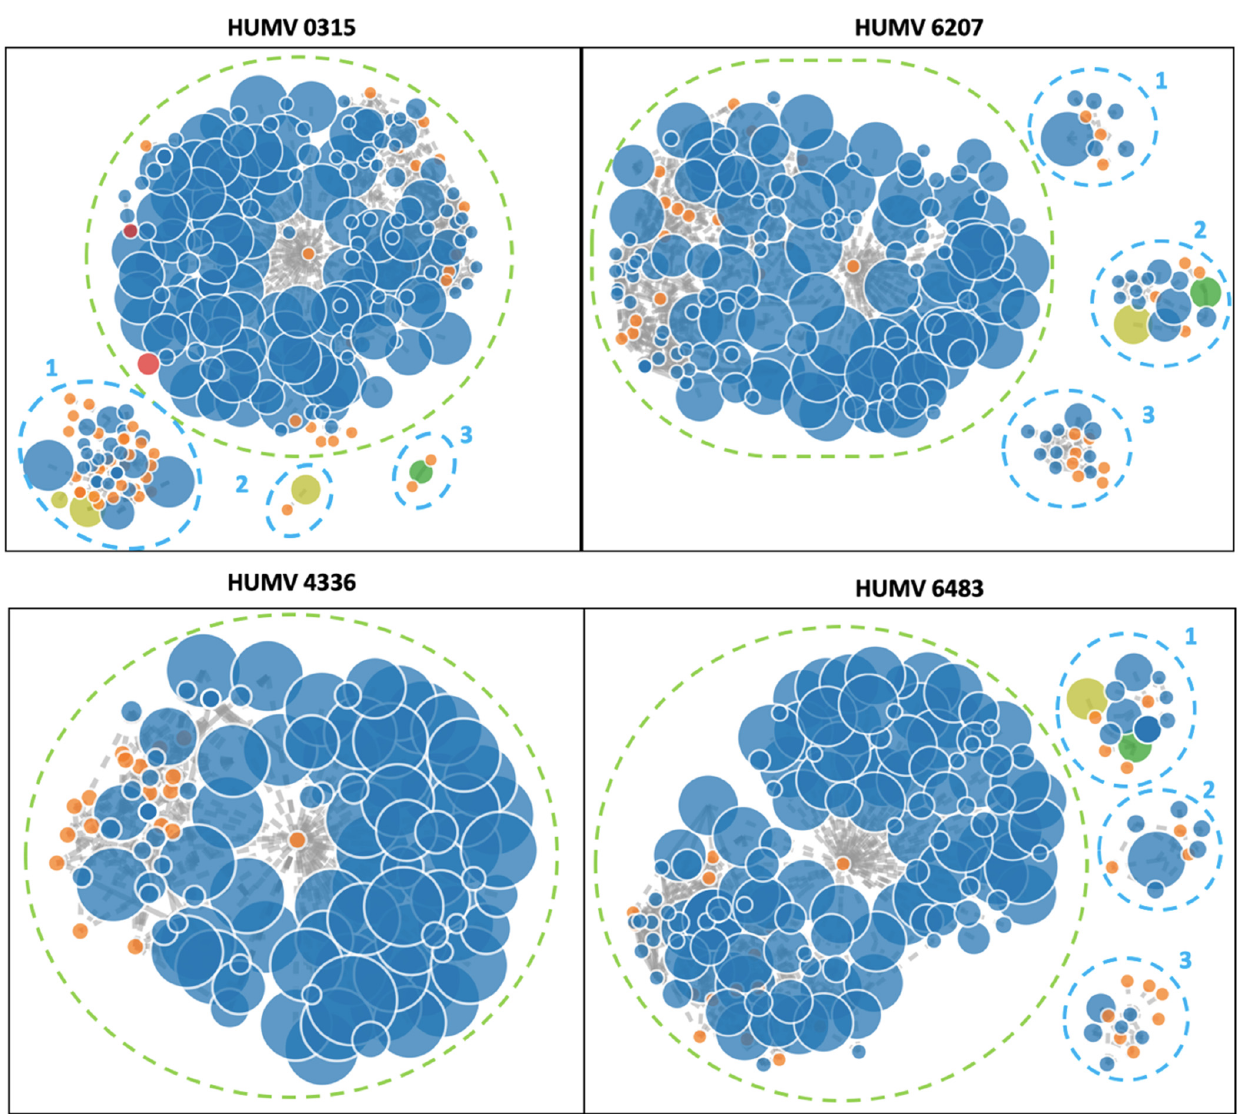
Figure 4. PLACNETw reconstruction of A. pittii draft genomes. Contigs are shown in blue nodes and in orange the reference genomes. The contigs node’s sizes are proportional to their length. The other color nodes represent contigs with specific proteins: yellow-green with RIP (replication initiation protein), red with REL (relaxases), and green with both. The dotted blue line shows the rounded plasmid predicted structures and the green-dotted lines show the chromosomes.